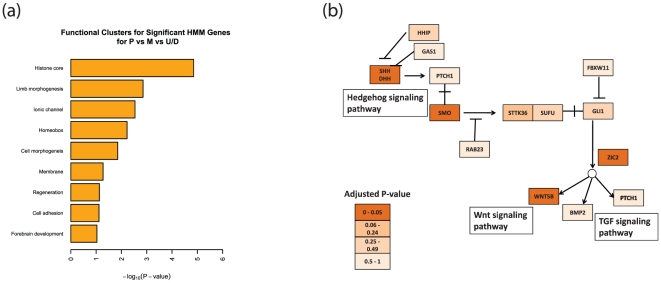
Functional enrichment analysis of the “hotspot” genes.A total of 722 “hotspot” genes were identified by applying ANOVA analysis to the chromatin states. Enriched functions and pathways were identified by using DAVID. (a) Representative enriched functional categories. (b) The Hedgehog signaling pathway is significantly enriched (p-value = 0.008). The genes were color-coded based their corresponding adjusted p-values obtained from ANOVA analysis.